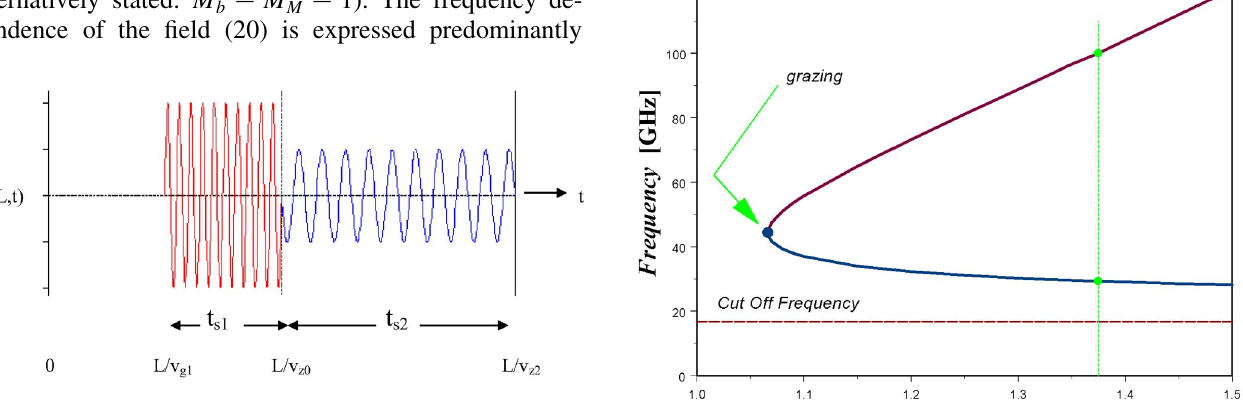
FIG. 4. (Color) The temporal waveform dependence of the field of a radiation wave packet emitted in free space in the forward direction from an e -beam bunch entering the wiggler ( z (cid:1) 0 ) at t (cid:1) 0 , and observed at the wiggler exit ( z (cid:1) L ).